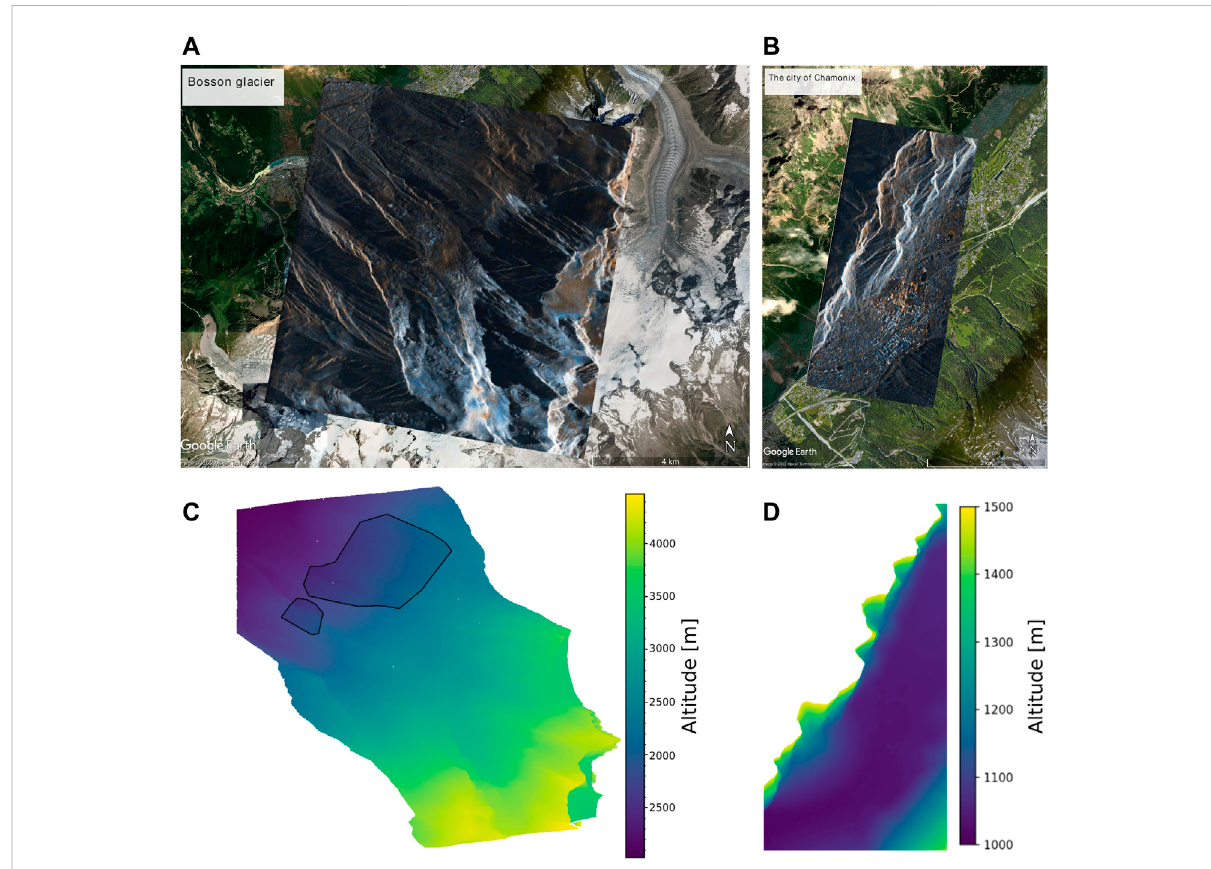
FIGURE 2 (A,B) OverlayofthePAZimageontheopticimagecoveringtheBossonsglacier (A) andChamonix (B) .ThePAZimageisatemporalmeanofthe three images studied here, displayed in amplitude with the HH channel in orange and the HV channel in blue. The same threshold is used for the visualizationofbothpolarimetricchannels(computedas μ +3 σ fromthemean μ andthestandarddeviation σ oftheamplitudeofbothimages).Small amplitude differences due to building orientation can be seen in the Chamonix image. (C,D) Altitude for each pixel of the SAR images over the Bossonsglacier (C) andtheChamonixarea (D) .OntheBossonsglacierDEM,theblackpolygonscorrespondtothestableareasusedinSection6.3to study the in fl uence of the central point